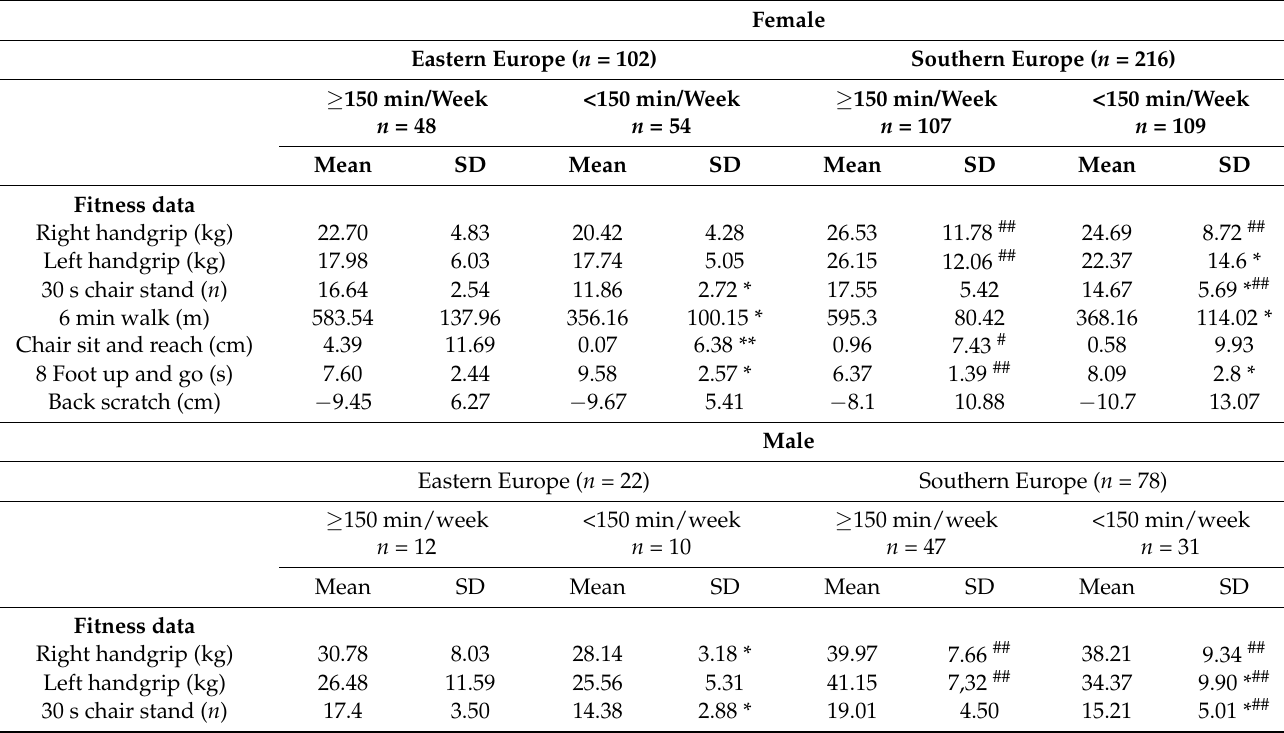
Table 3. Physical fitness results by gender in relation to the physical activity